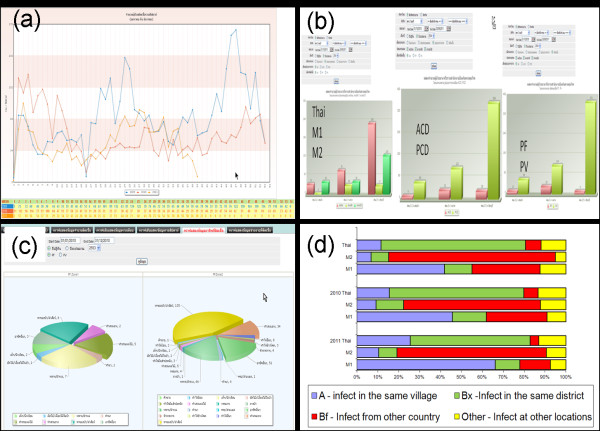
Examples of situation and trend analyses as part of the eMIS presentations. (a) Motion line graph of weekly numbers of cases, January 2009-August 2011; (b) Bar graph of cases with different characteristics by selected operational unit; (c) Pie chart of cases among different occupations at risk in selected provinces; (d) Bar graph of case investigations on self-reported locations of infection.